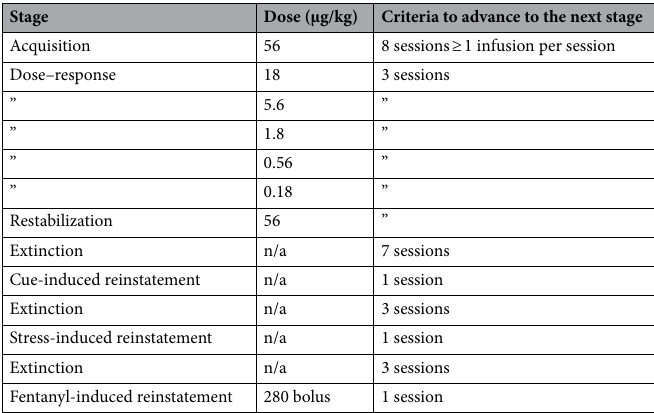
Table 1. Stages of the intravenous fentanyl self-administration